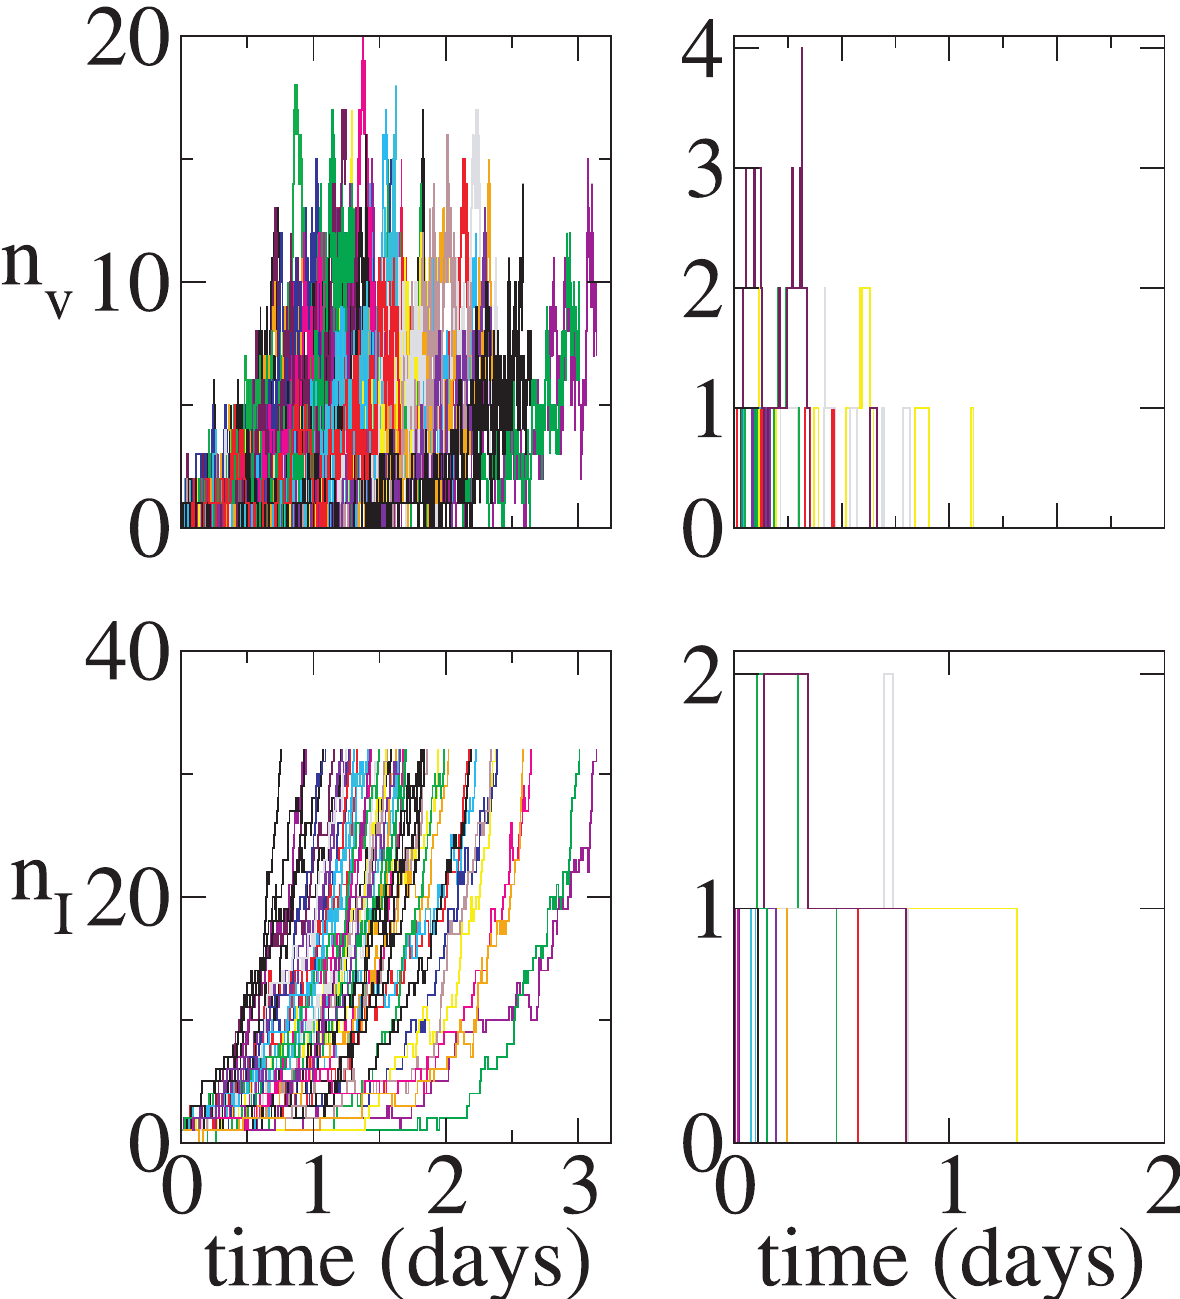
Figure 6. Continuous model. Representative time series. Initial condition: n V ~ 0 , n I ~ 1 . Left column: 100 realizations that lead to infection. Right Column: 100 realizations that lead to